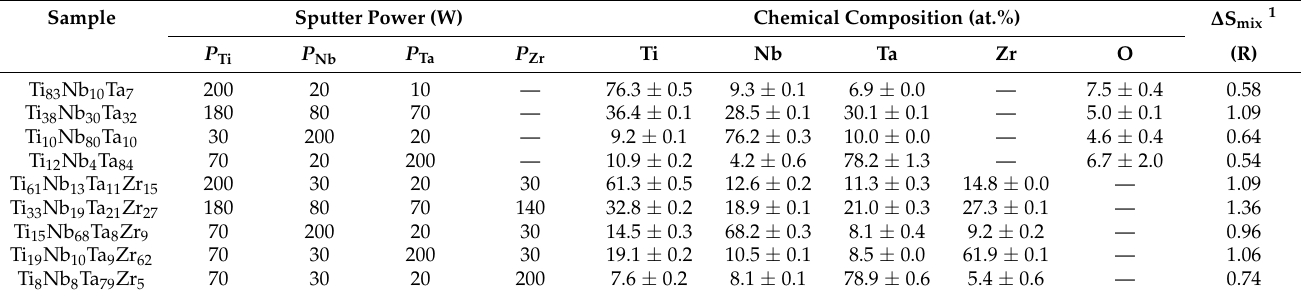
Table 1. Co-sputtering parameters and chemical compositions of TiNbTa and TiNbTaZr films. Sample Sputter Power